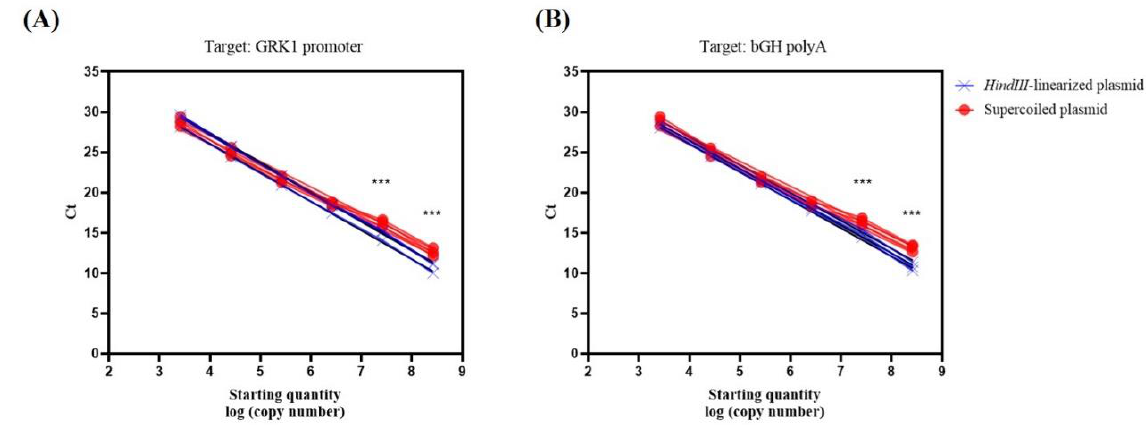
Figure 2. Standard curves obtained in three independent experiments targeting the GRK1 promoter ( A ) and the bGH polyA signal ( B ), using undigested plasmid (supercoiled) and linearized plasmid. Regardless of the target sequence, the Ct values between equimolar points of both standard curves are slightly different with higher values obtained using the supercoiled plasmid. These differences are statistically significant when higher starting quantities of DNA are used (*** p < 0.001, Mann–Whitney test, n = 3). The data shown in each graph represent the value for each technical replicate.